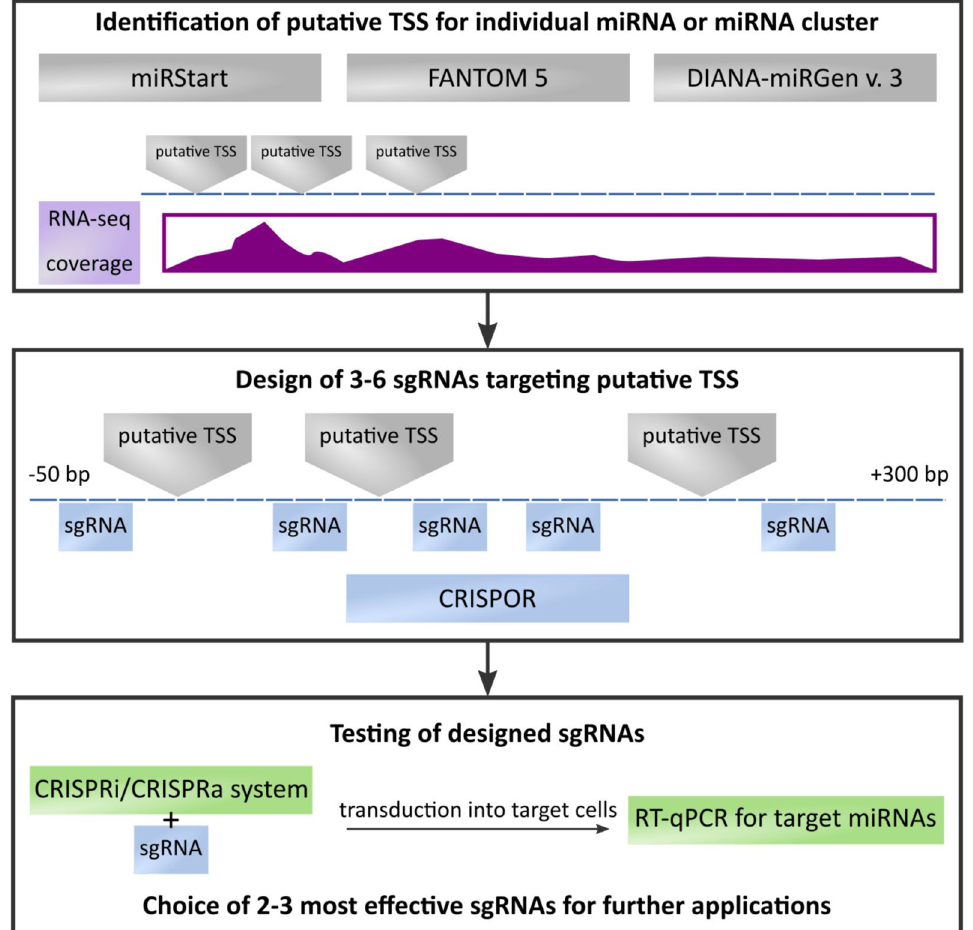
Figure 1. The strategy of the application of CRISPRi/CRISPRa approach for specific repression or activation of individual miRNAs or miRNA clusters. TSS—transcription start